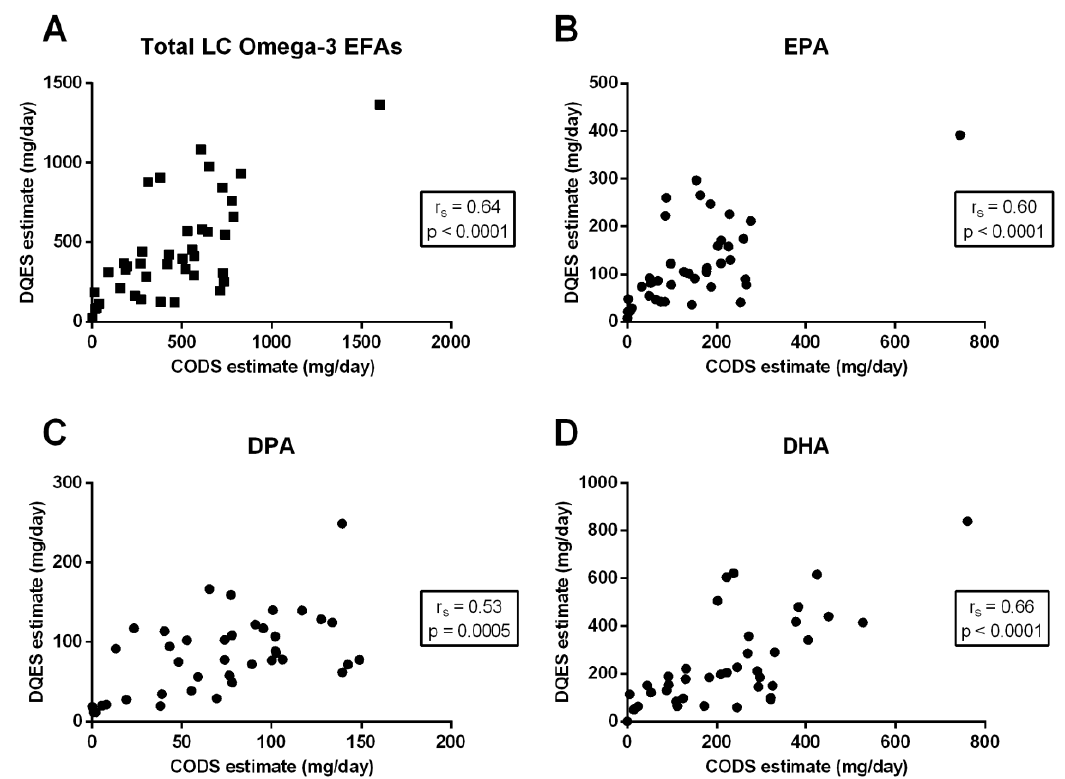
Figure 1. The relationship between calculated dietary long-chain (LC) omega-3 essential fatty acid (EFA) intake, quantified using the Spearman’s correlation coefficients (r s ), and the Clinical Omega-3 Dietary Survey (CODS) versus the Dietary Questionnaire for Epidemiology Studies (DQES) v3.2, for ( A ) total LC omega-3 EFAs; ( B ) eicosapentaenoic acid (EPA); ( C ) docosapentaenoic acid (DPA); and ( D ) docosahexaenoic acid (DHA).